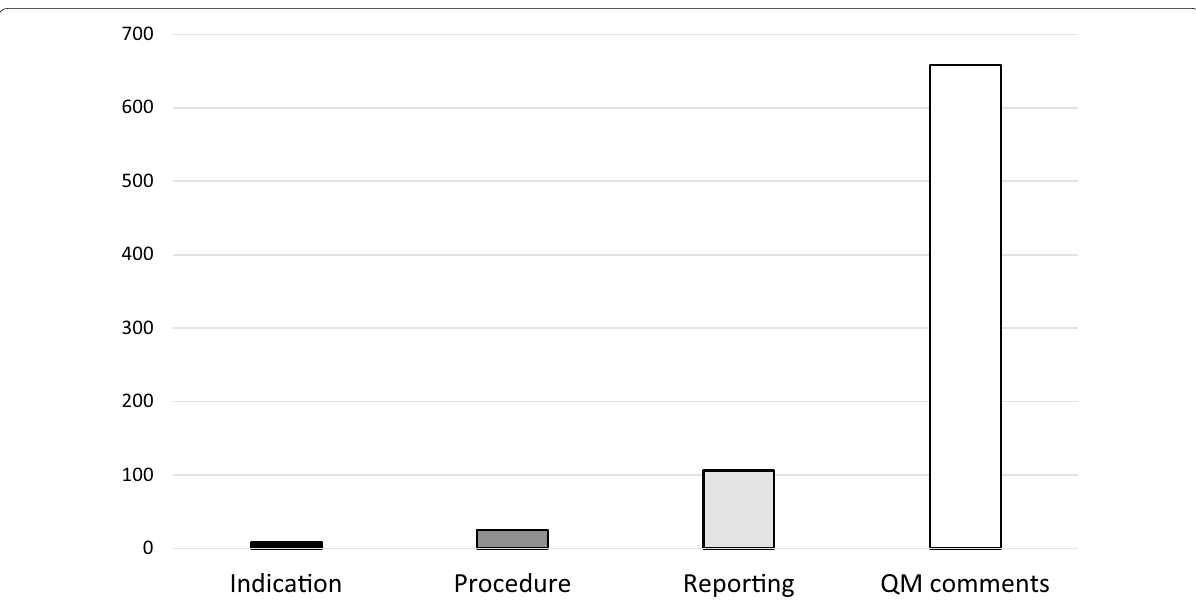
8, 5.8%), procedure ( n 25, 18.0%), and = = 973). In examinations affected by QM events, QM comments further addressed =